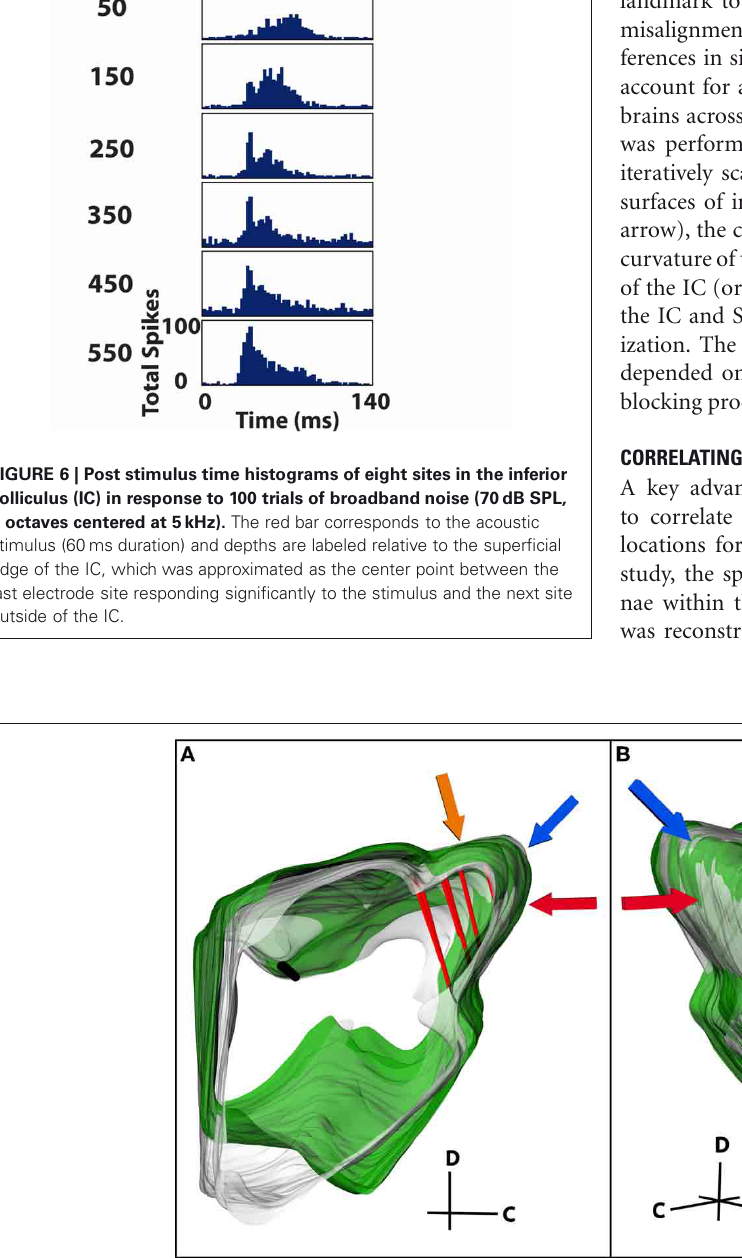
extending from the dorsal to the lateral surface (orange arrow), and the caudal surface of the IC (red arrow). The midbrains were anchored together on the lateral edge of the consistent reference track (gray arrow) and rotated and scaled relative to that point until the new midbrain (green) was normalized to the standard midbrain (gray). C, caudal; D, dorsal; L,